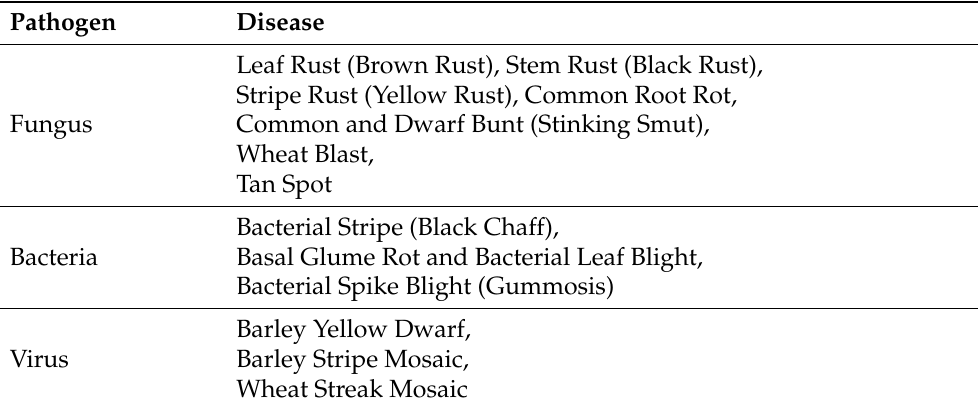
Table 2. Some wheat disease types and causing pathogens